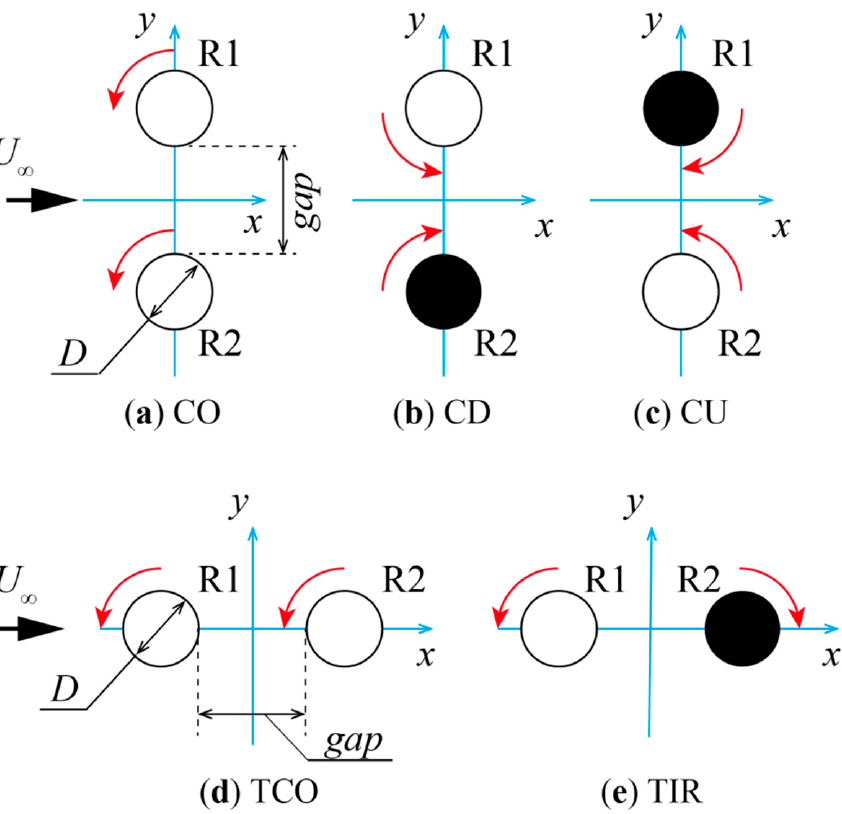
Figure 3. Specific layouts of a pair of VAWT rotors: ( a ) co-rotating (CO) layout; ( b ) counter-down (CD) layout; ( c ) counter-up (CU) layout; ( d ) tandem co-rotating (TCO) layout; ( e ) tandem inverse-rotating (TIR) layout.